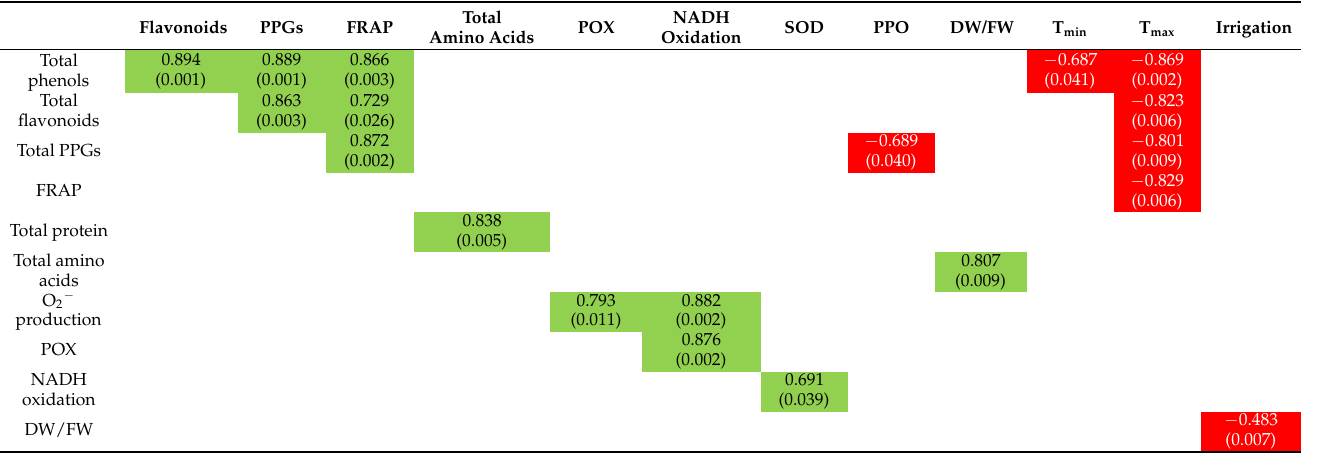
Table 3. Significant correlations and p -values (in parentheses) between parameters and environmen- tal